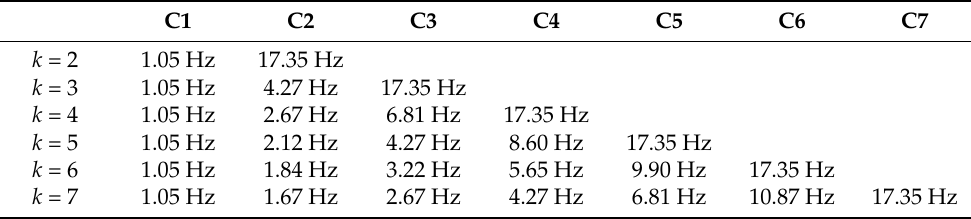
Table 2. Average frequencies of the clusters, for each grouping from k = 2 to k = 7, obtained considering the weight set